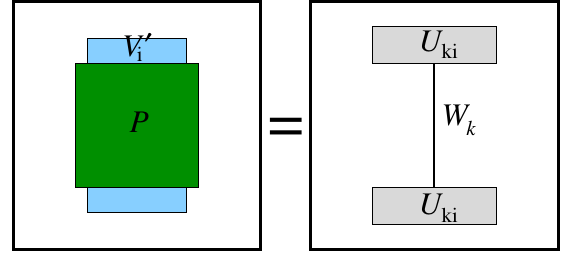
FIG. 8. According to Conjecture 1, (C1), we can write P (cid:2) i ¼ U W (cid:2) i , where W PV 0 ki k j k is a (stringlike) unitary k i j operator that describes a process in which a pair of quasiparticles F k , (cid:3) k are created and then moved to regions F 1 , 2 [Fig. 7(b)], and where U ki is an operator acting within F 1 [ F 2 .